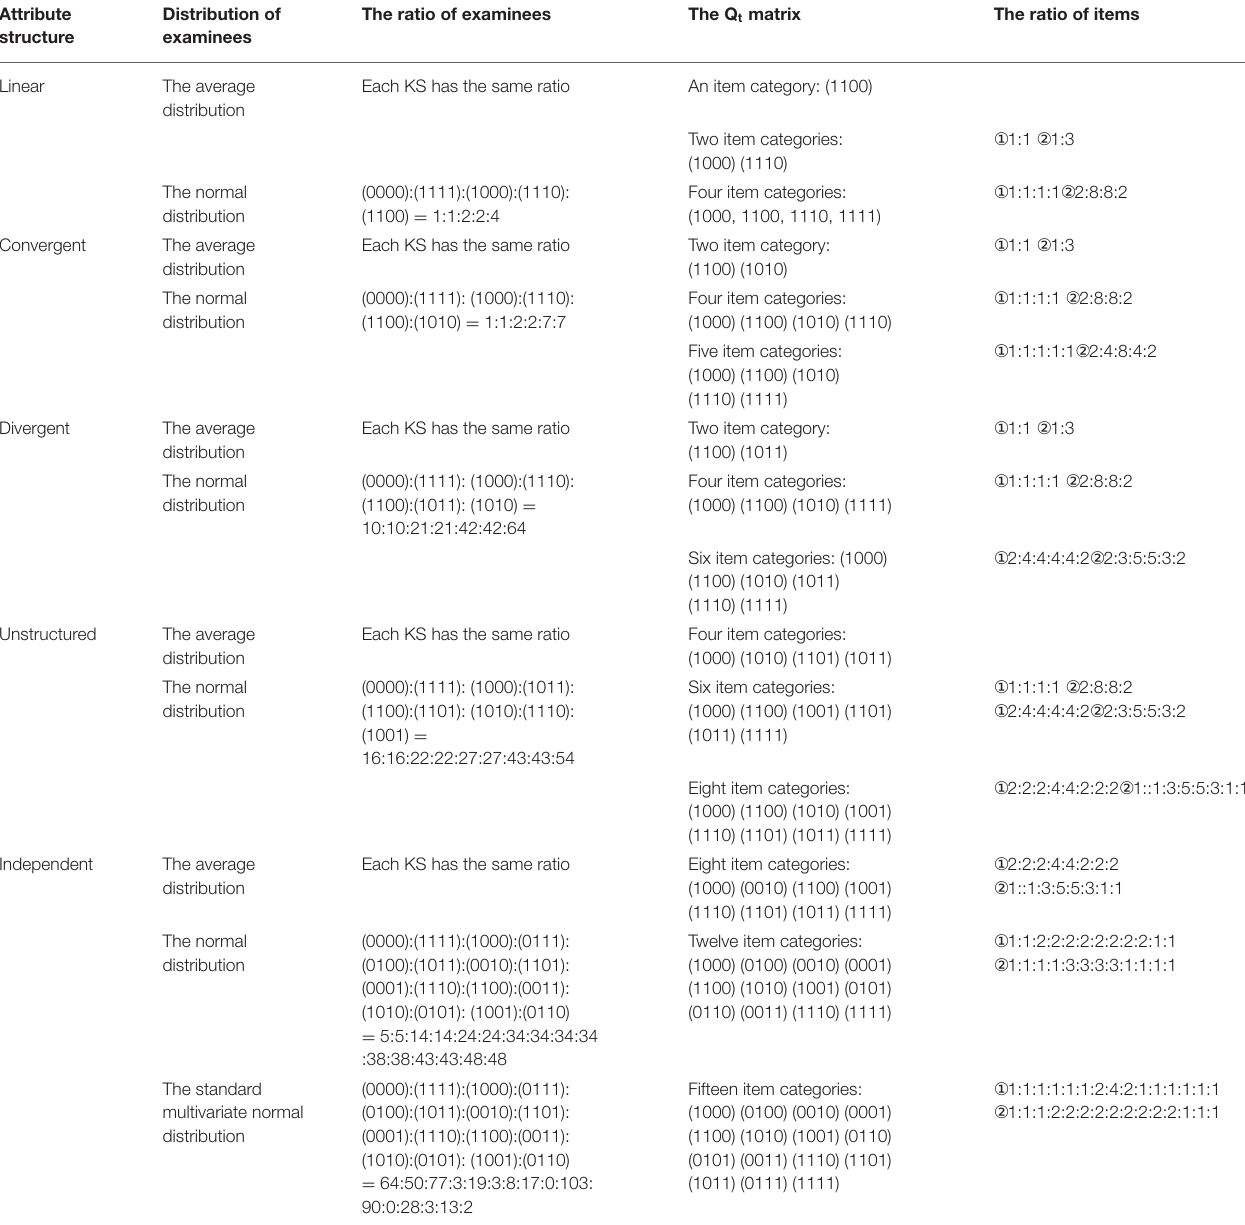
TABLE 2 | The distributions of examinees and the proportions of items for five different hierarchical structures. Attribute